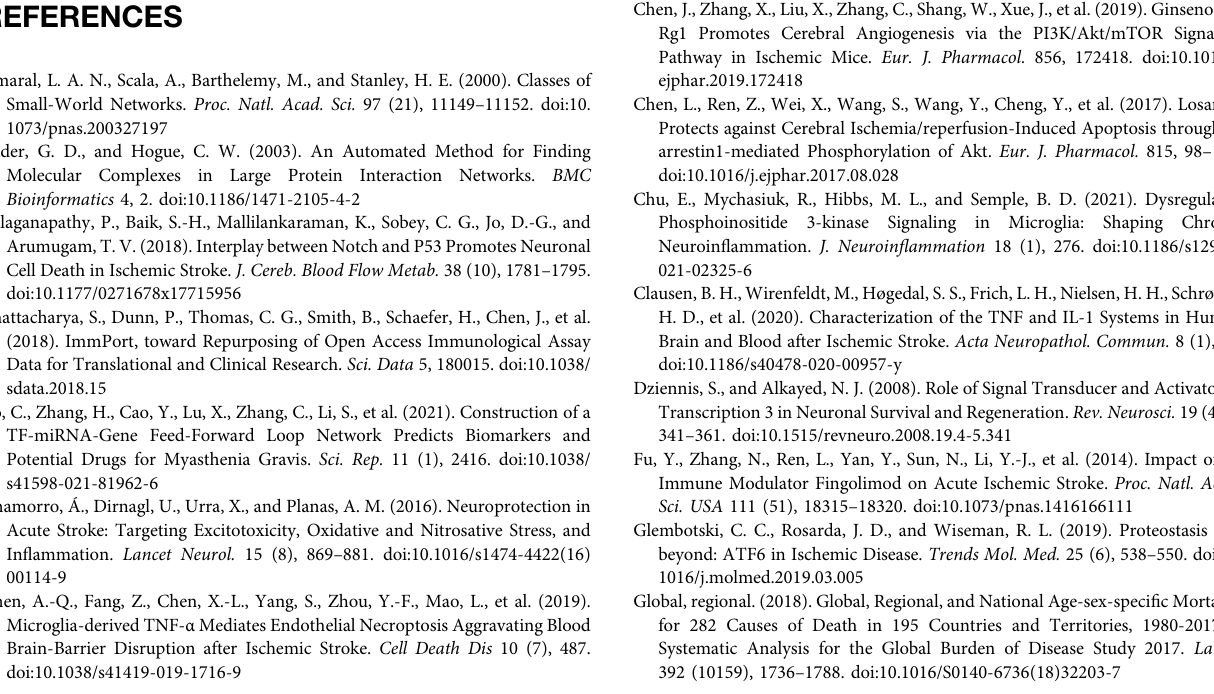
Supplementary Figure S1 | Distribution of immune genes for ischemic stroke. Supplementary Figure S2 | The basic topological features of IA-CFMSN. SupplementaryFigureS3 | Theregulatoryrelationshipofa3-nodecompositeFFL and part of Cytokine-cytokine receptor interaction pathway with IL6 as hub